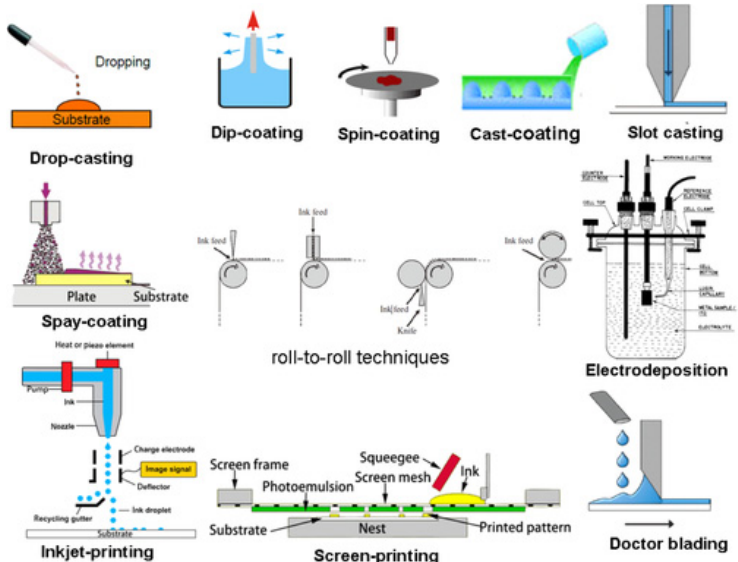
Figure 4. Common coating or printing techniques [20] . Reprinted with permission from ref. [20] . © 2021 John Wiley and Sons.